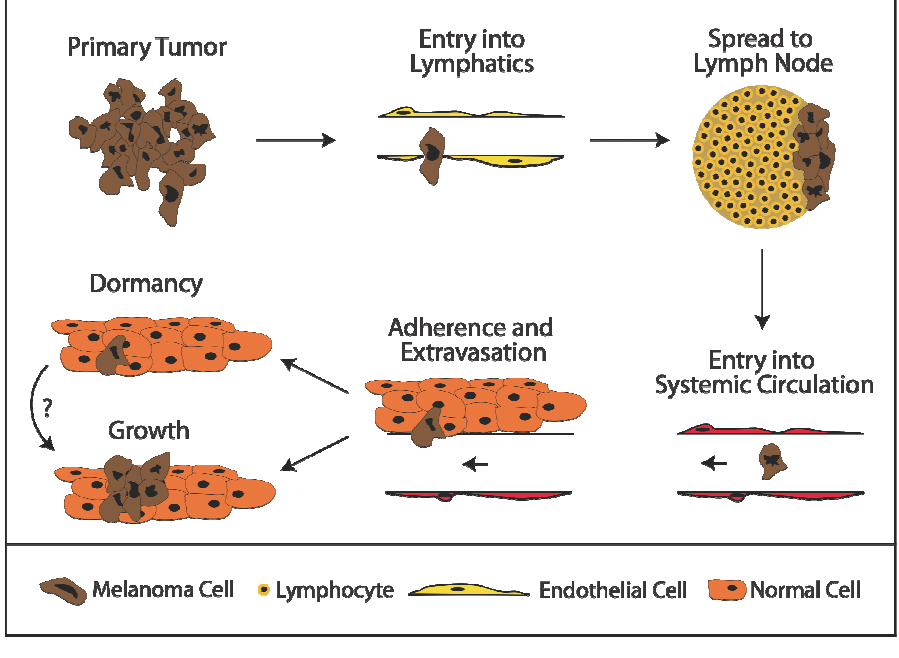
Figure 2. Steps in Melanoma Metastasis. After formation of a primary tumor, melanoma cells are thought to enter into lymphatic vessels, traverse to the lymph node, and subsequently enter into systemic circulation via the thoracic duct. After reaching systemic circulation, cells must adhere to the microvasculature of a target organ, extravasate,